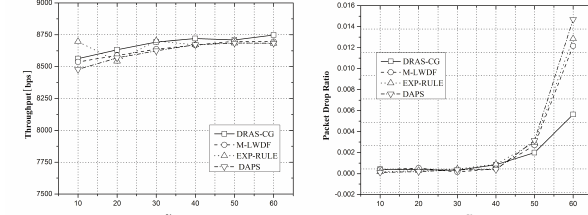
Figure 7: Packet Drop Ratio of VoIP Service